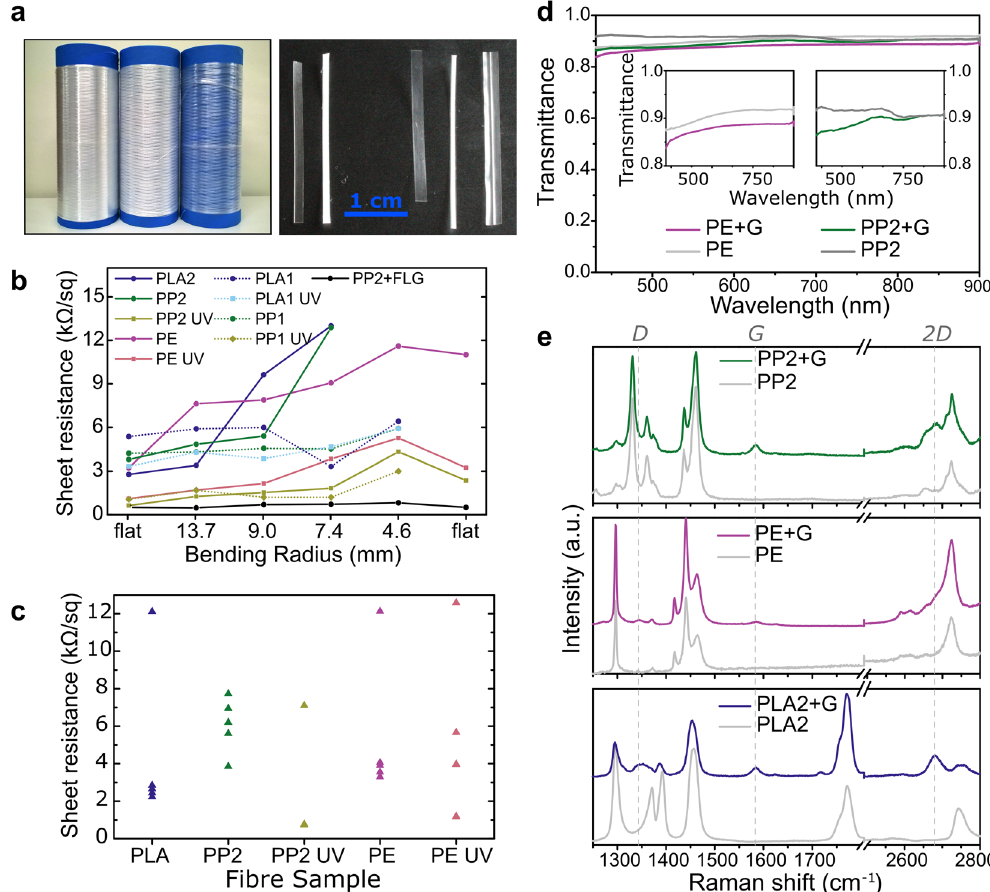
Figure 1. ( a ) Photo of the fibres in reels, left to right: PP2, PE, PLA2 (left) and of the fibres cut to ca . 3 cm length, left to right: PP1, PLA1, PP2, PLA2, PE (right). ( b ) Sheet resistance as a function of bending radius for samples of each coated fibre. In-plane measurements were performed before and after the bending cycle (“flat” in the x-axis). ( c ) Distribution of sheet resistance values for several coated samples of each fibre. ( d ) Transmittance as a function of wavelength for bare PP2 and PE, and graphene-coated ( + G) PP2 and PE fibres. Insets show detail of transmittance for PP2 and PE. ( e ) Raman spectra of the bare fibres and graphene-coated ( + G) fibres. Vertical dashed lines at 1345, 1685 and 2685 cm − 1 correspond to the D, G and 2D peak positions,